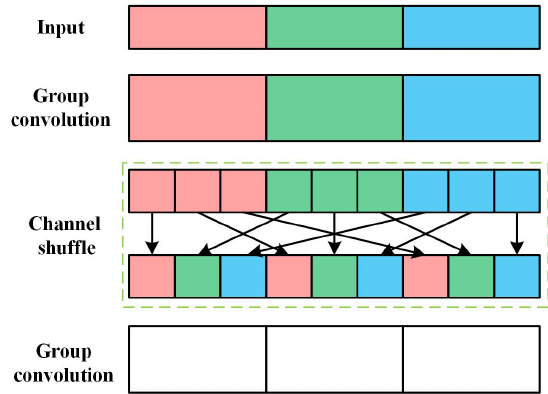
Figure 2. The basic principle of channel shuffle.